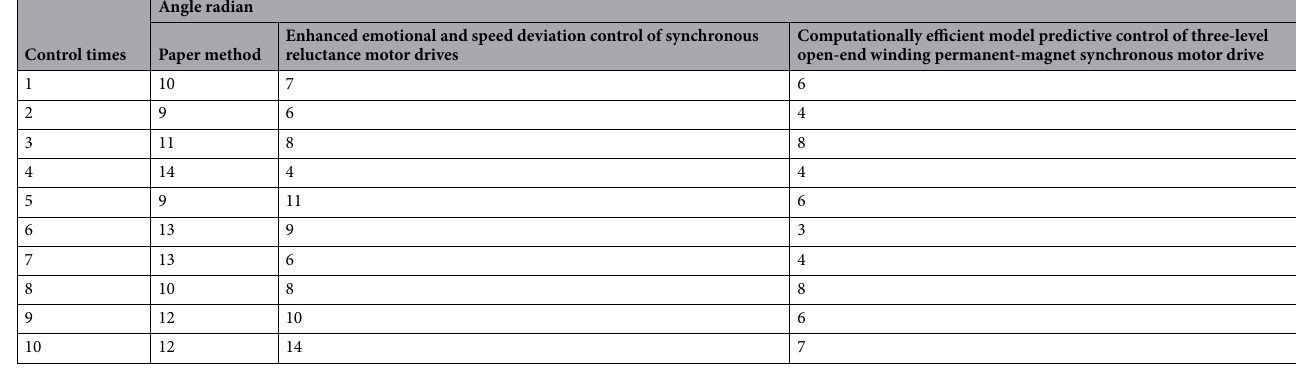
Table 1. Comparison of motor angle control